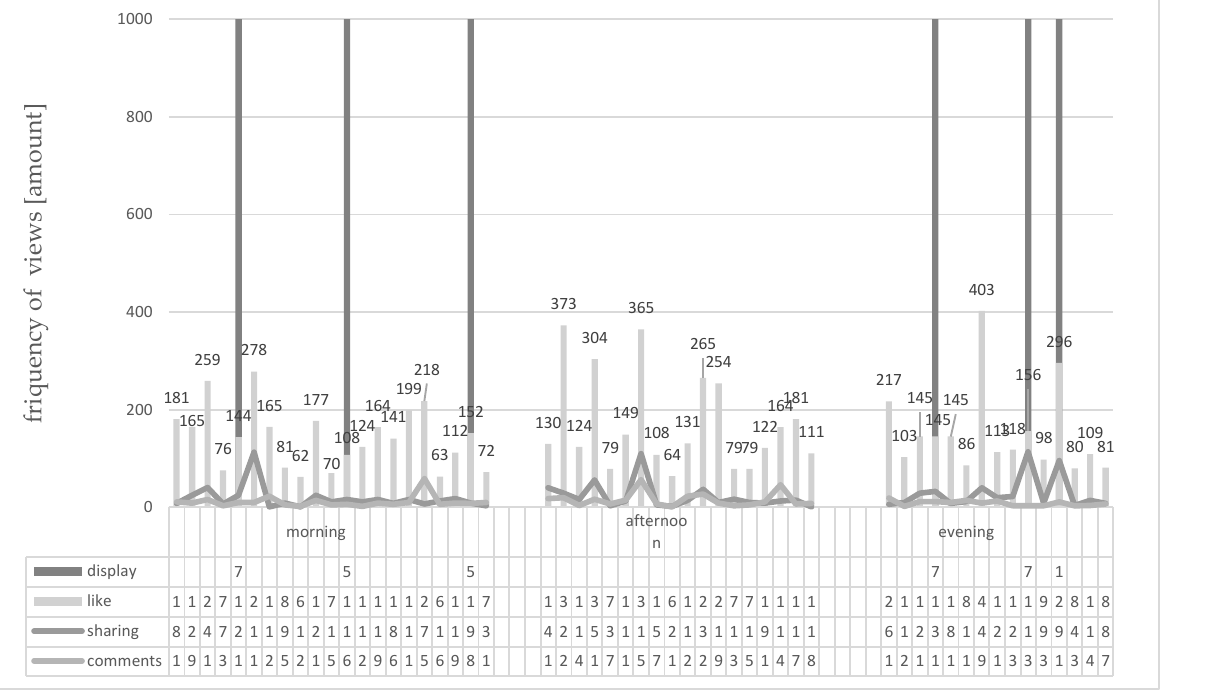
Figure 4. Summary of the intensity of engagement of Facebook users between 1 and 21 July 2020. Source: authors’ own elaboration based on Facebook data. As we can see in Figure 4, particular interest in forest management content was rec- orded in the morning and evening hours. In the afternoon, activity was somewhat lower; still, strong interest was observed in the content that particularly attracted attention. There is an increase in active users who, in addition to following the profile, share content as well as comment on posted materials. This channel attracts the interest of followers, and those who manage it will maintain the required regularity of publishing content. Another tool within social media that is actively used for digital information sharing is Instagram. As specified in the methodological information, the channel is intended to